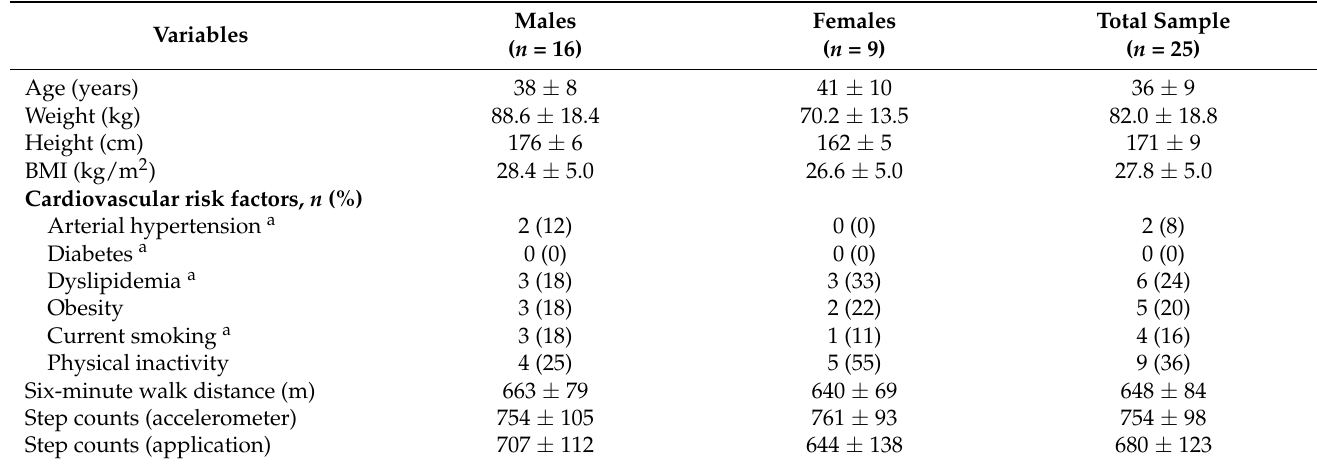
Table 2. General characteristics of the sample used for cross-sectional validation ( n = 25).